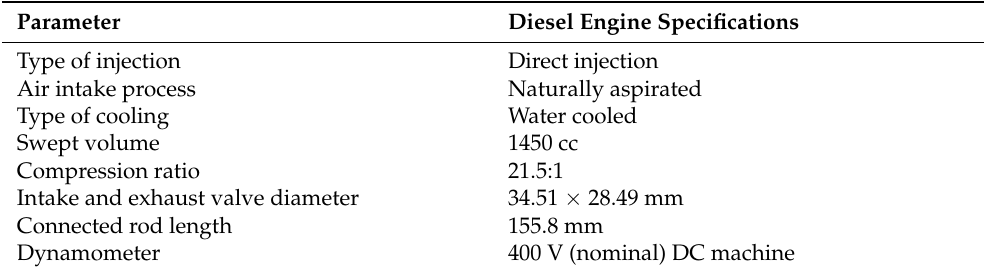
Table 1. Technical data of automotive 30 test bed diesel